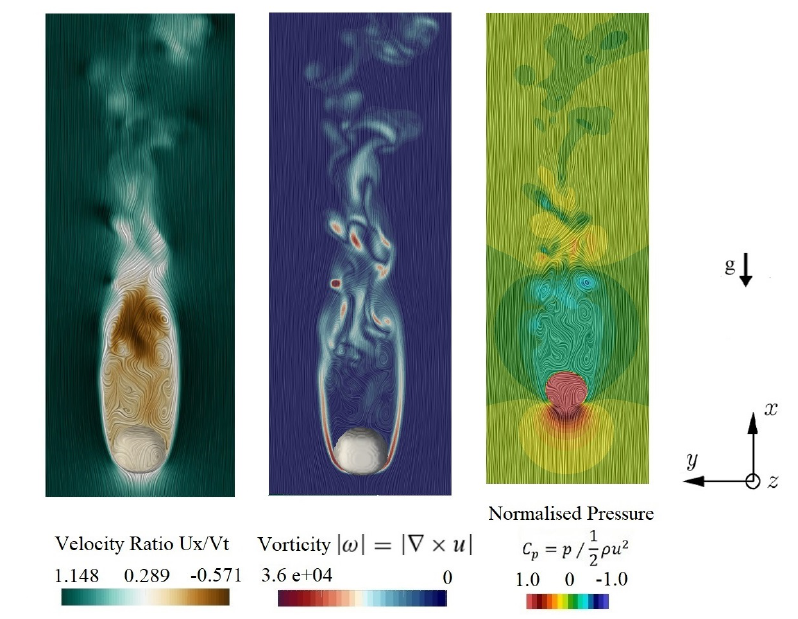
Figure 9. Instantaneous streamlines coloured with the normalised stream-wise velocity ( left ), the vorticity magnitude ( middle ) and the normalised pressure ( right ) for the case D3T0, at about 2.3